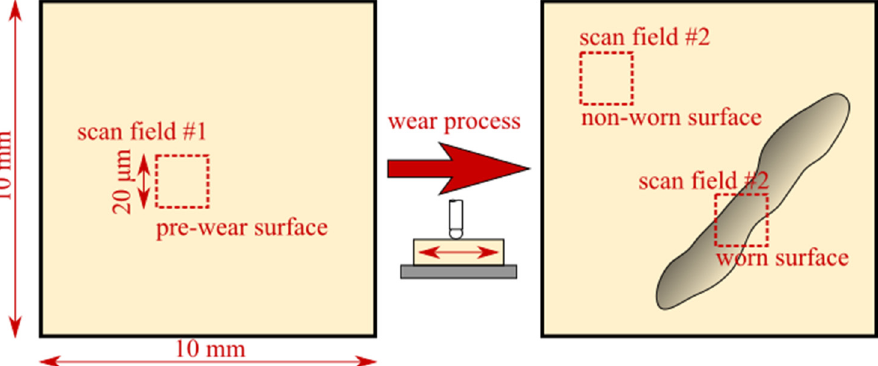
Figure 5. AFM scan fields throughout the wear process over the area of the sample (not in